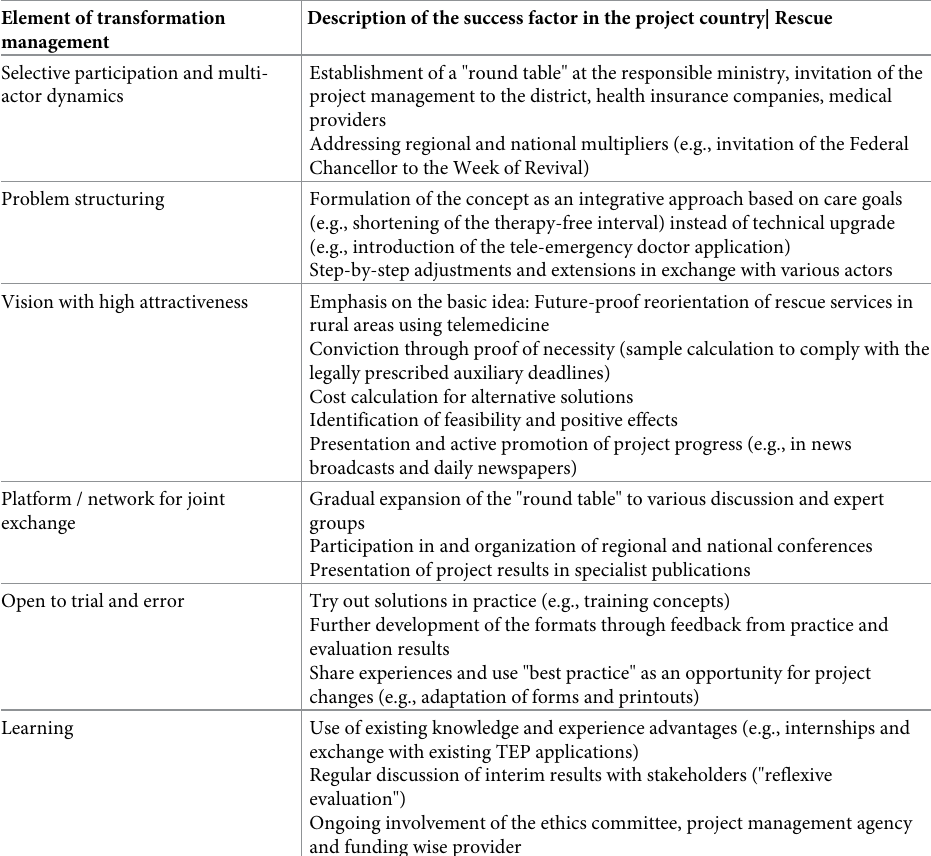
Table 9. Success factors of transition process in the project Rural|Rescue [structured according to